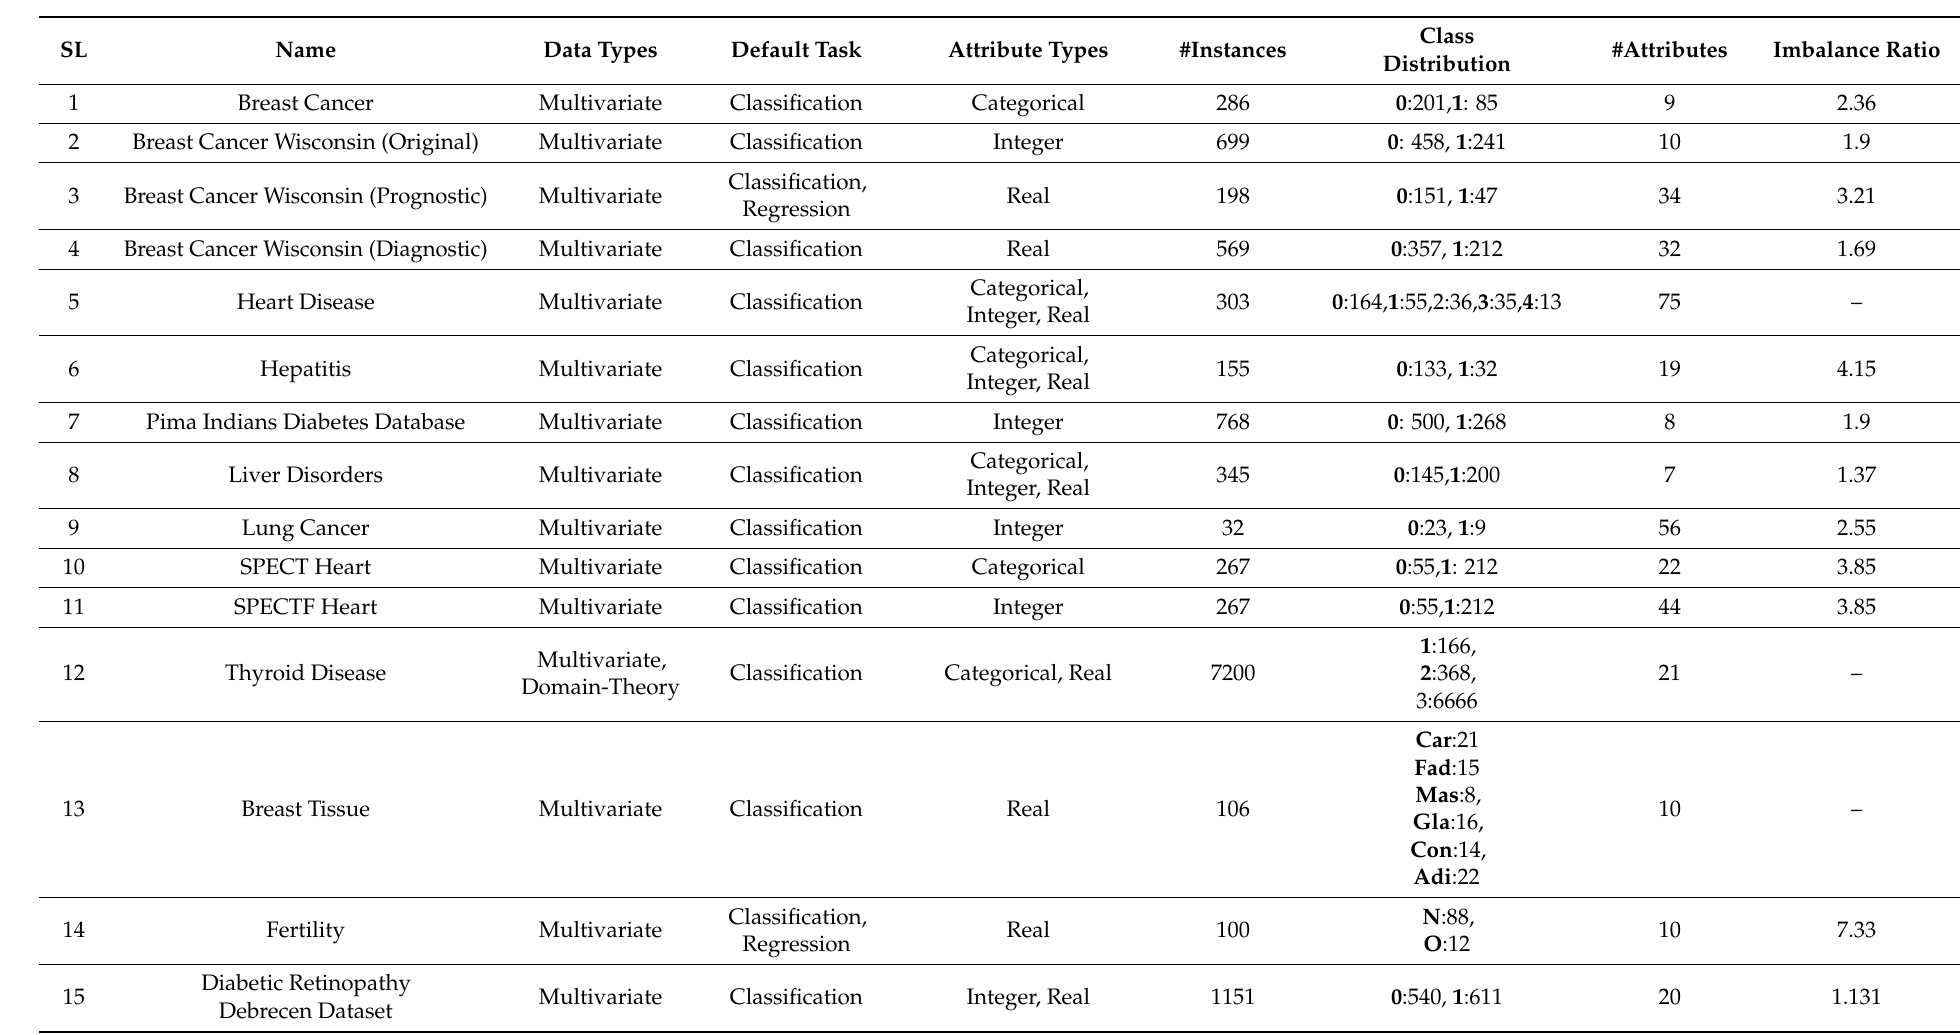
Table 1. Summarized details of various clinical datasets